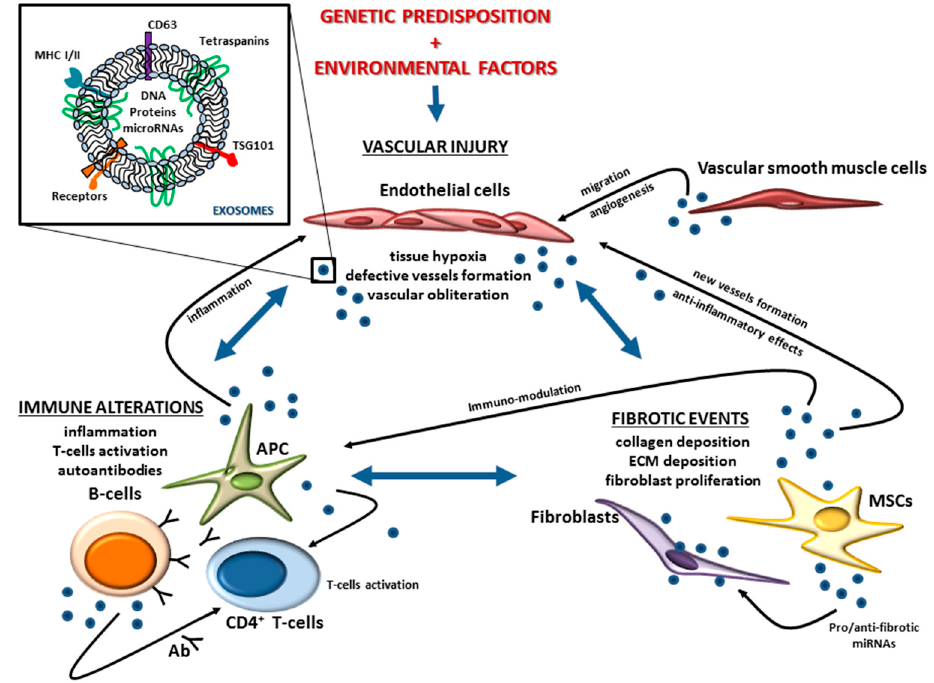
Figure 1. Possible role of exosomes in SSc: Messengers between immune, vascular, and fibrotic components. Genetic predisposition and environmental factors contribute to the onset of SSc. SSc is characterized by a progressive and systemic multi-organ fibrosis, which is preceded by vessel vasculopathy, inflammation, and autoimmunity. Exosomes, membrane-surrounded nano-vesicles, are produced by several types of cells (immune cells, endothelial cells, MSCs, fibroblasts, and vascular smooth muscle cells) and are implicated in inter-cellular communication. Exosomes can carry several types of molecules, i.e., DNA, microRNA, and proteins, which are able to regulate di ff erent processes in the target cell, thus influencing its behavior. Immune cells produce exosomes that can act on the same immune cells or on the cells of other tissues, such as endothelial cells regulating, for example, the inflammatory processes. MSCs-derived exosomes have immune-modulatory properties, contain miRNAs with anti- or profibrotic activity and regulate the formation of new vessels. Exosomes secreted by vascular smooth muscle cells are up-taken by endothelial cells, influencing the migratory properties of target cells and angiogenesis. Blue arrows mean interconnection between vasculopathy, autoimmunity, and fibrosis; black arrows mean exosomes a ff ecting target